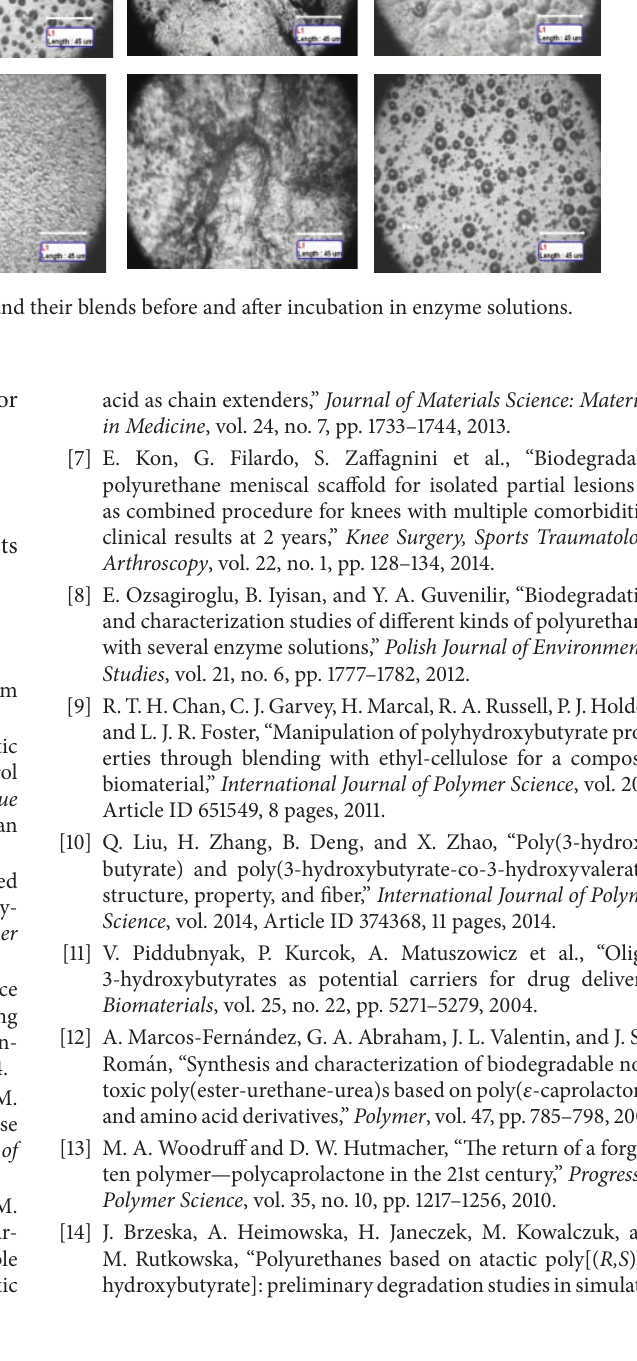
Figure 6: The surface structure of polyesterurethanes and their blends before and after incubation in enzyme solutions.